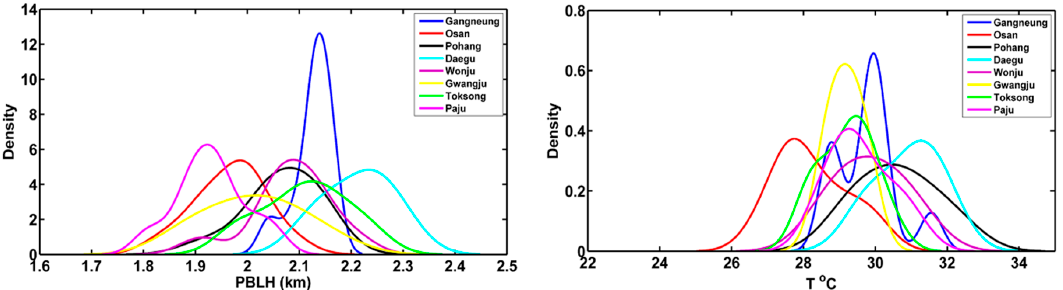
Figure 11. Distributions of PBLH and temperature (T) over different geographical stations.